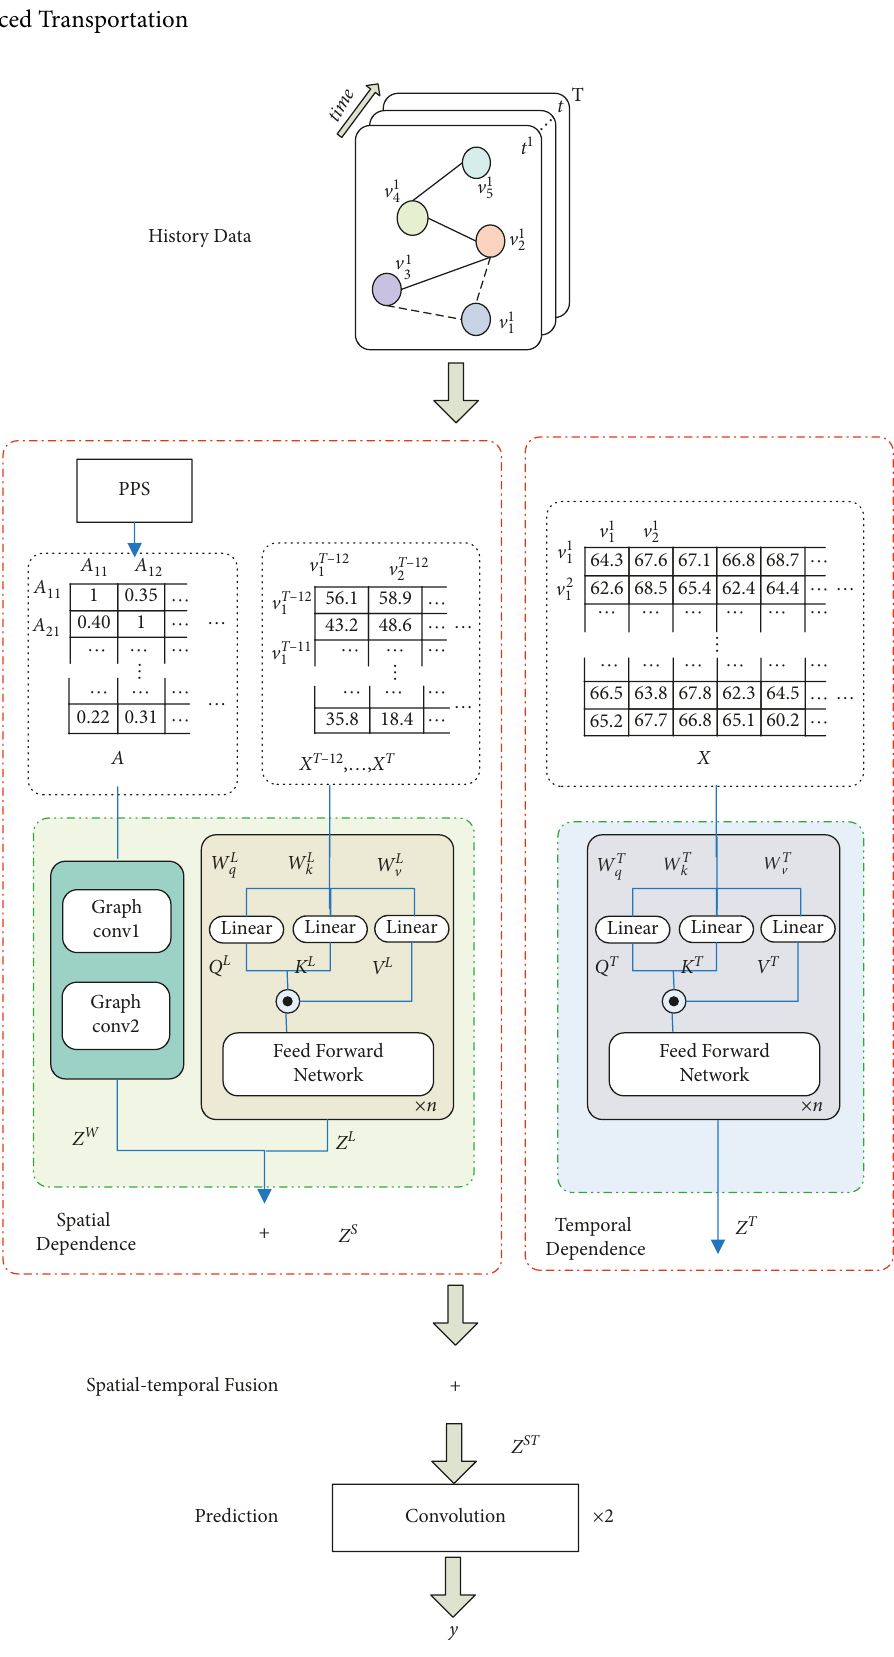
Figure 1: The framework of